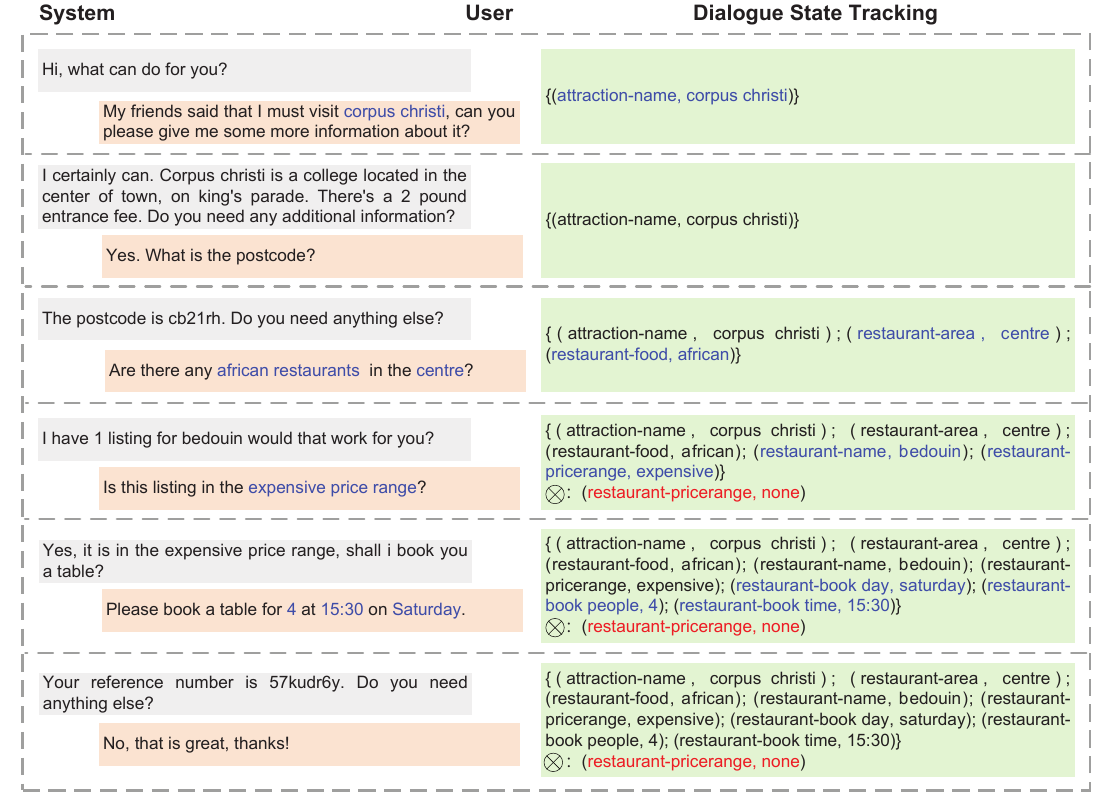
Figure 1. An example of dialogue state tracking. Each turn consists of a system response (grey) and a user utterance (orange). The blue colour denotes the new state appearing at that turn. The dialogue state tracker (green) tracks all the ( slot , value ) pairs until the current turn. “ (cid:78) ” represents the incorrect result marked with red colour which is predicted by some existing